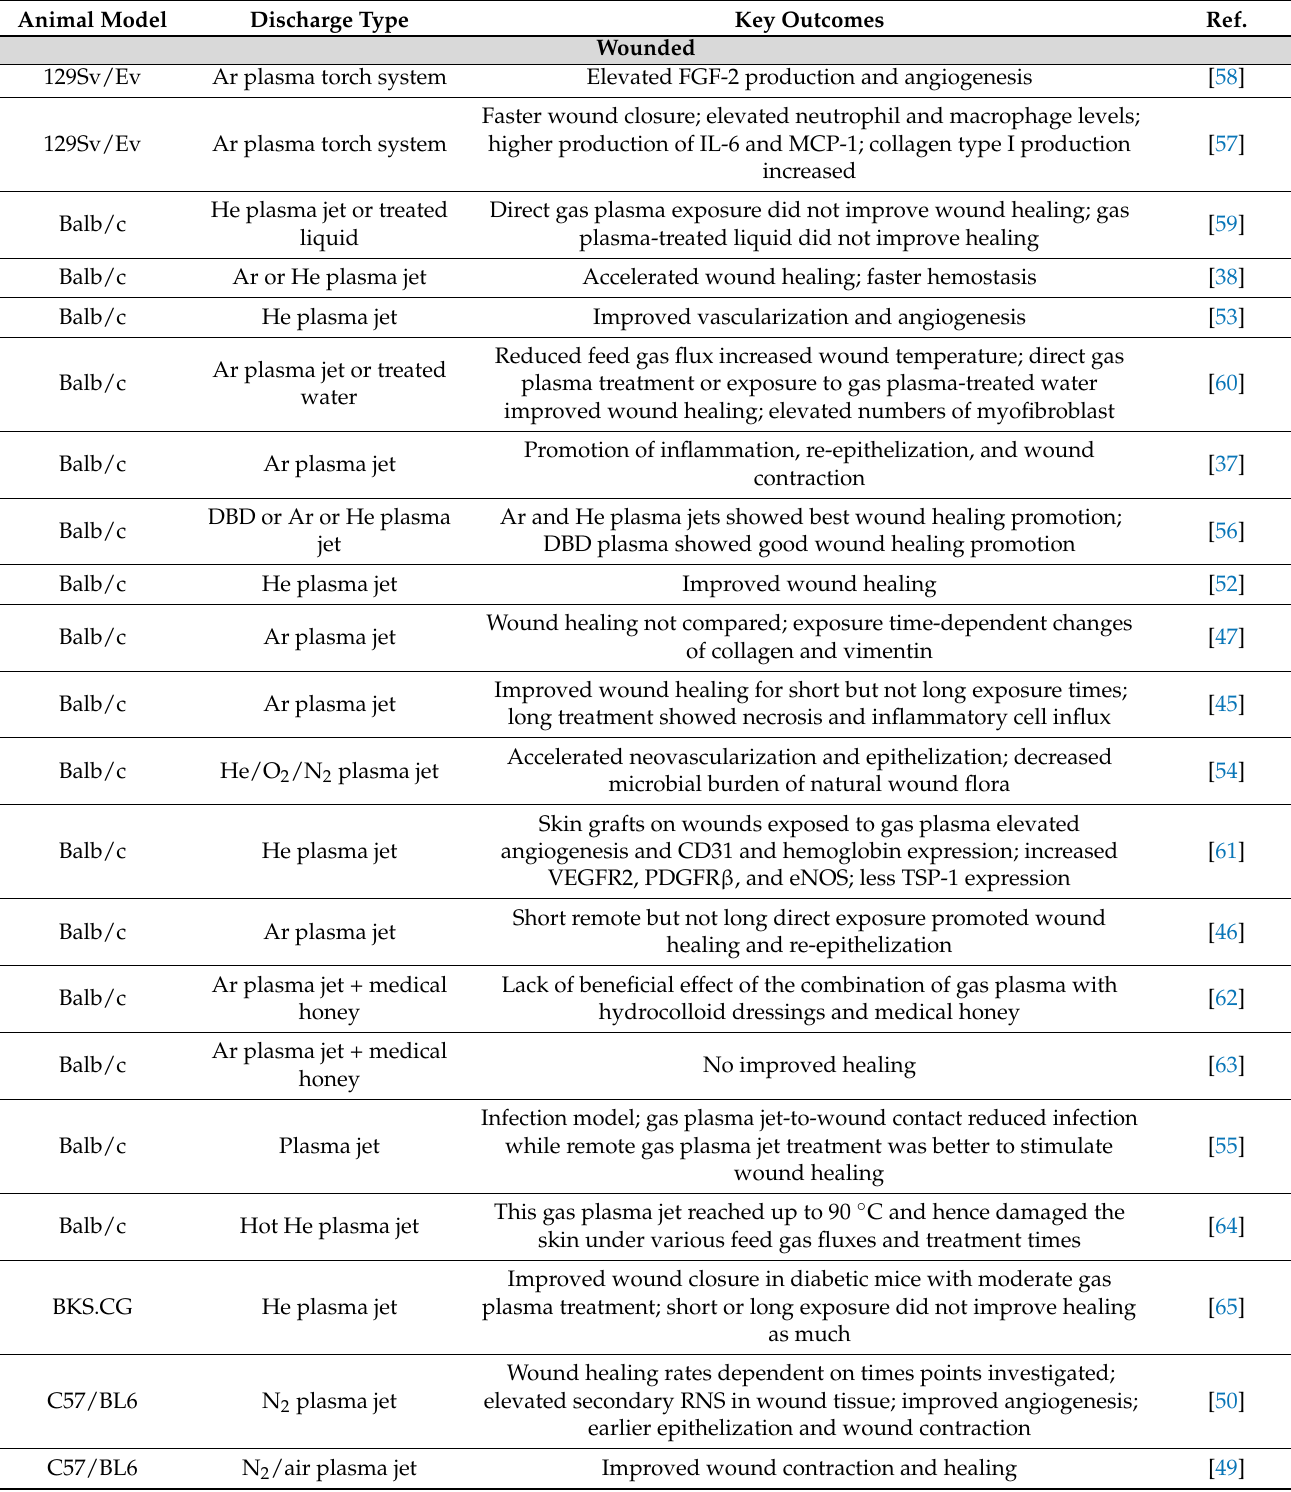
Table 1. Study overview on gas plasma-treated skin and wound healing in mice. Key Outcomes